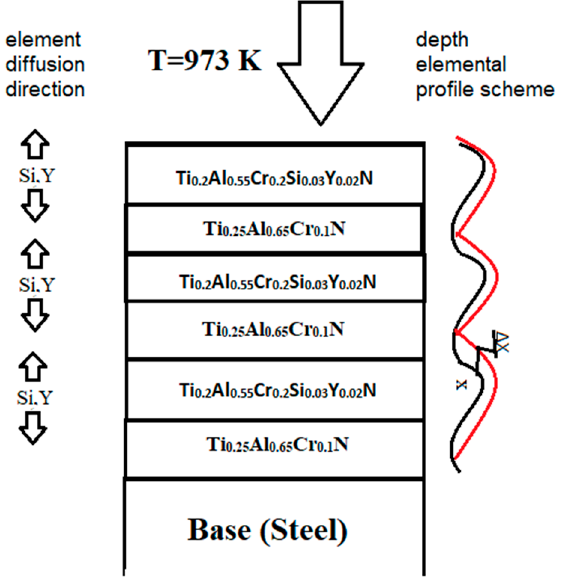
Figure 6. Scheme of diffusion occurring during atmospheric annealing at a temperature of 700 °C in the TiAlCrSiYN/TiAlCrN multilayer coating. On the right is a diagram of the depth distribution of the diffusing elements (Si, Y). The black line indicates the depth profile before heating; the red line represents the depth profile (Si, Y) after annealing; Δ X is the diffusion path of atoms (Si, Y).